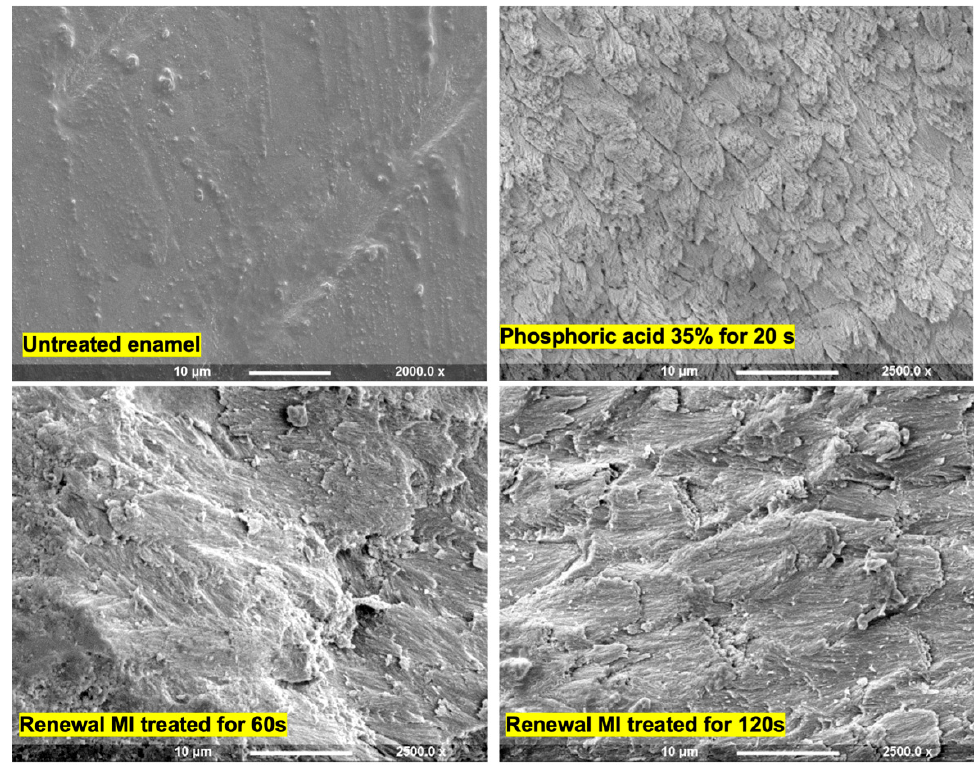
Figure 1. Representative SEM images of the enamel surface upon applying Renewal MI or phosphoric acid gel 37% for different times followed by rinsing with acetone and/or water.